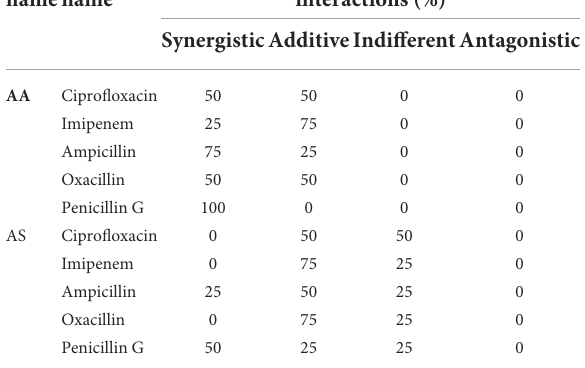
TABLE 3 Percentage of isolates with different synergy interactions of AA and AS with antibiotics. Drug Antibiotic Type of synergy